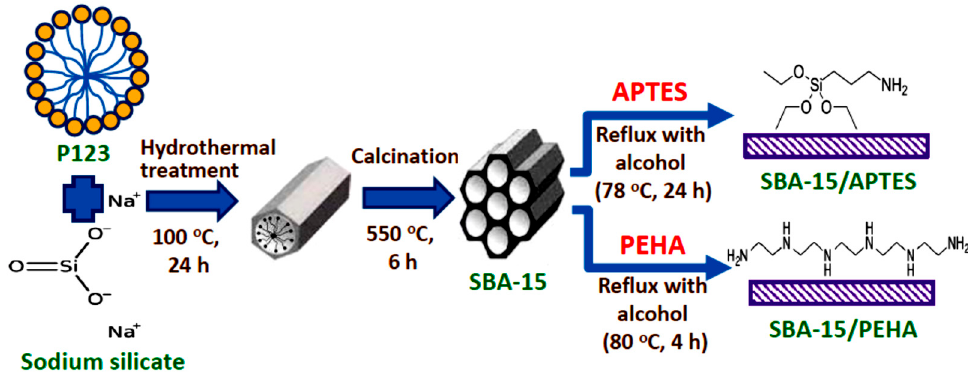
Figure 1. Schematic representation of SBA ‐ 15, SBA ‐ 15/APTES, and SBA ‐ 15/PEHA